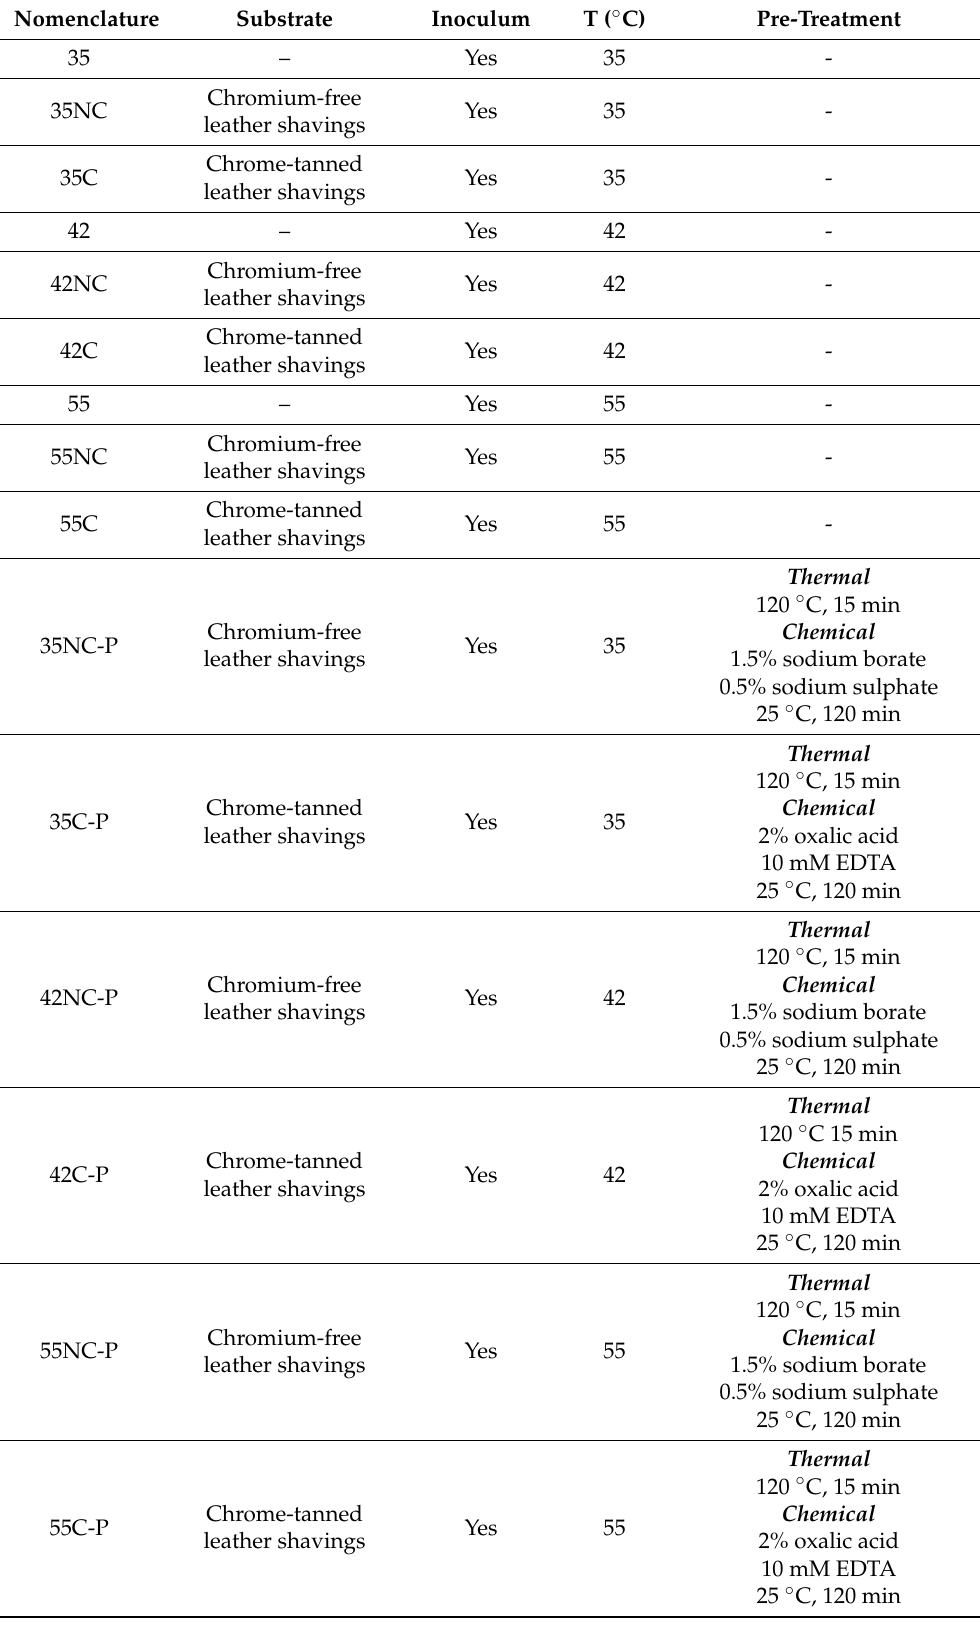
Table 3. Description of the experimental